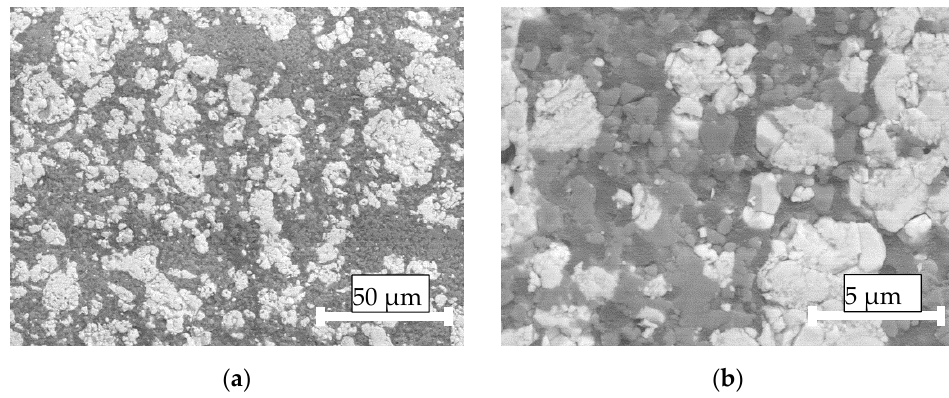
Figure 8. The microstructure of the central region of the sample from Figure 7b. Magnification is ( a )—1000×, ( b )—5000×.